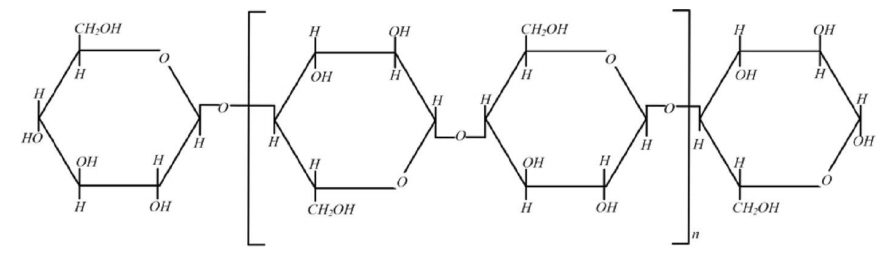
Figure 1. Chemical structure of cellulose macromolecular chain.